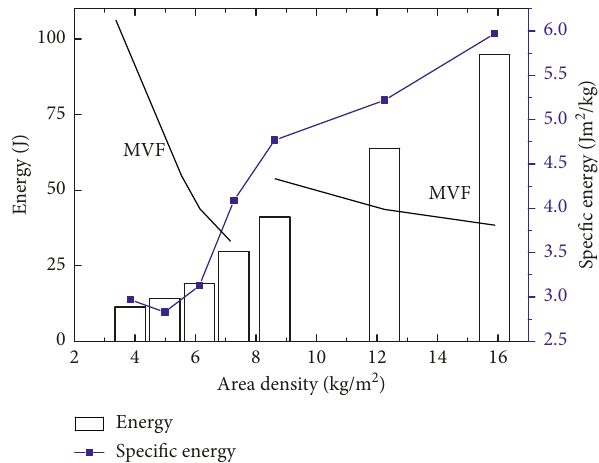
Figure 17: Absorbed energy and specific energy of BFML plates under drop-weight impact.